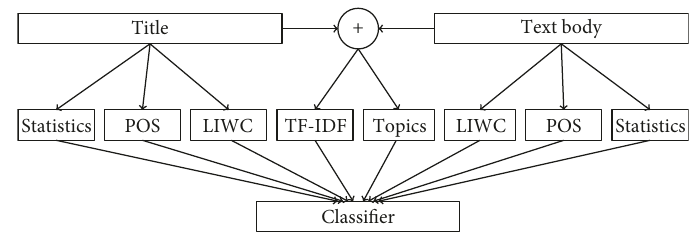
Figure 3: The model ’ s structure for Reddit